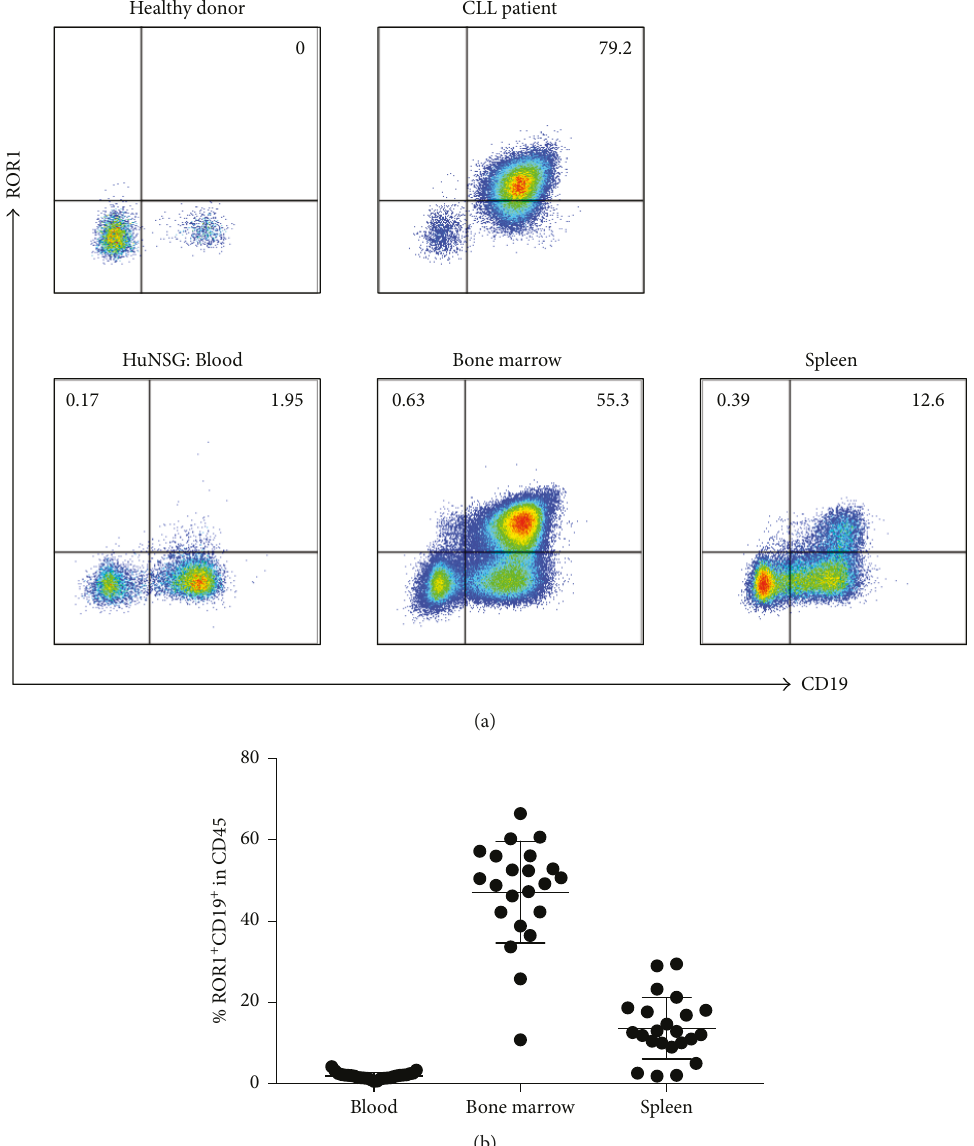
Figure 2: ROR1 expression on B cells in huNSG mice. (a) Flow cytometry staining of CD19 + and ROR1 + cells in PBMCs isolated from a healthy donor and a CLL patient (upper panel) and cells isolated from the blood, bone marrow, and spleen (lower panel) of huNSG mice. Samples were pregated as live cells, singlet cells positive for human CD45. The numbers indicate the frequency of CD19 + and ROR1 + cells within human CD45 + cells. (b) Composite data from 3 independent experiments are shown. Each data point represents one individually analyzed mouse. Horizontal lines represent the mean and